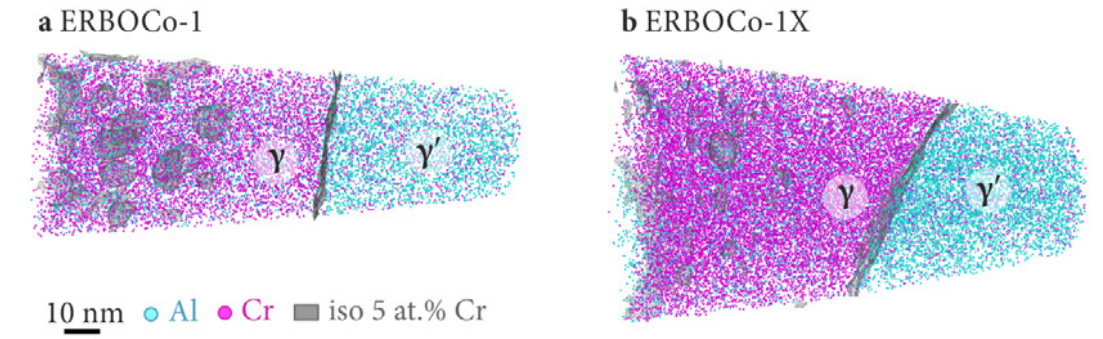
Figure 4. Atom probe tomography (APT) reconstructions of ( a ) ERBOCo-1 and ( b ) ERBOCo-1 showing 2% of the Al and Cr atoms and a 5% Cr iso-concentration surface for visualization.